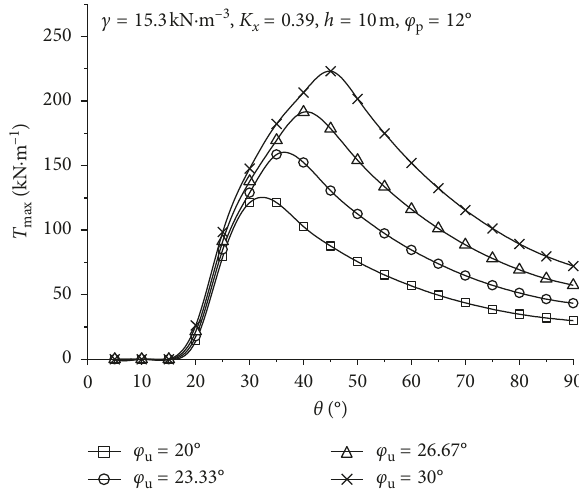
Figure 4: Changing of the ultimate tensile force in the membrane with the slope angle.